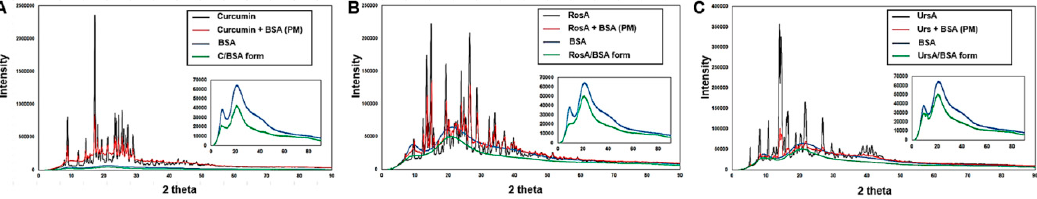
Figure 3. X-ray di ff raction results with BSA nanoparticles of ( A ) curcumin, ( B ) RosA, and ( C ) UrsA, along with the data on pure compounds (drug or BSA powder) or physical